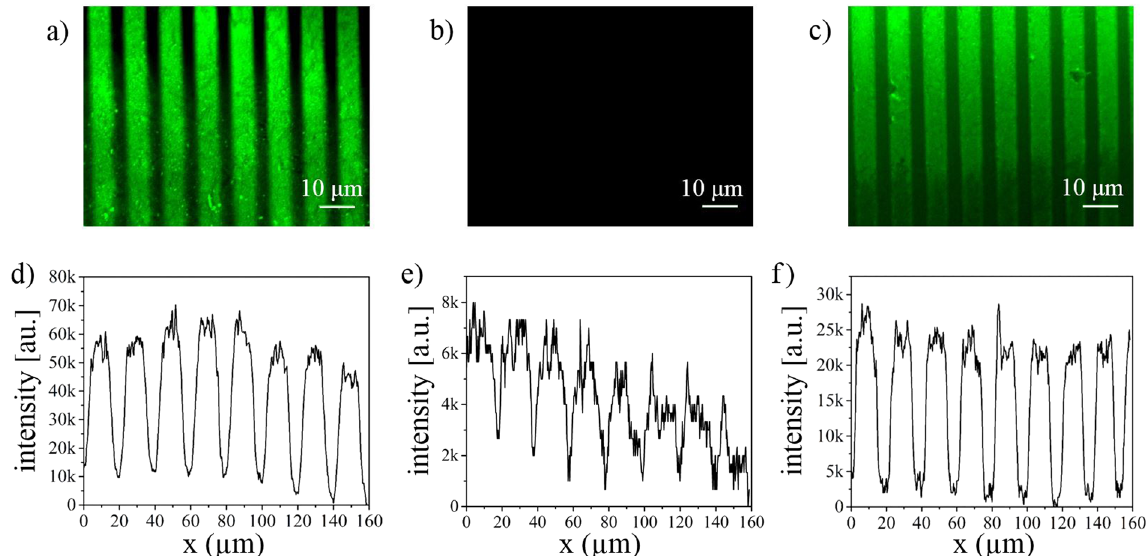
Figure 7. Fluorescence images of protein patterned PAm hydrogel and averaged intensity profiles. Collagen patterned on HH masks ( a ), no protein on the mask after the patterning ( b ) and protein totally transferred on PAm gel. All the images were captured at the same exposure time (200